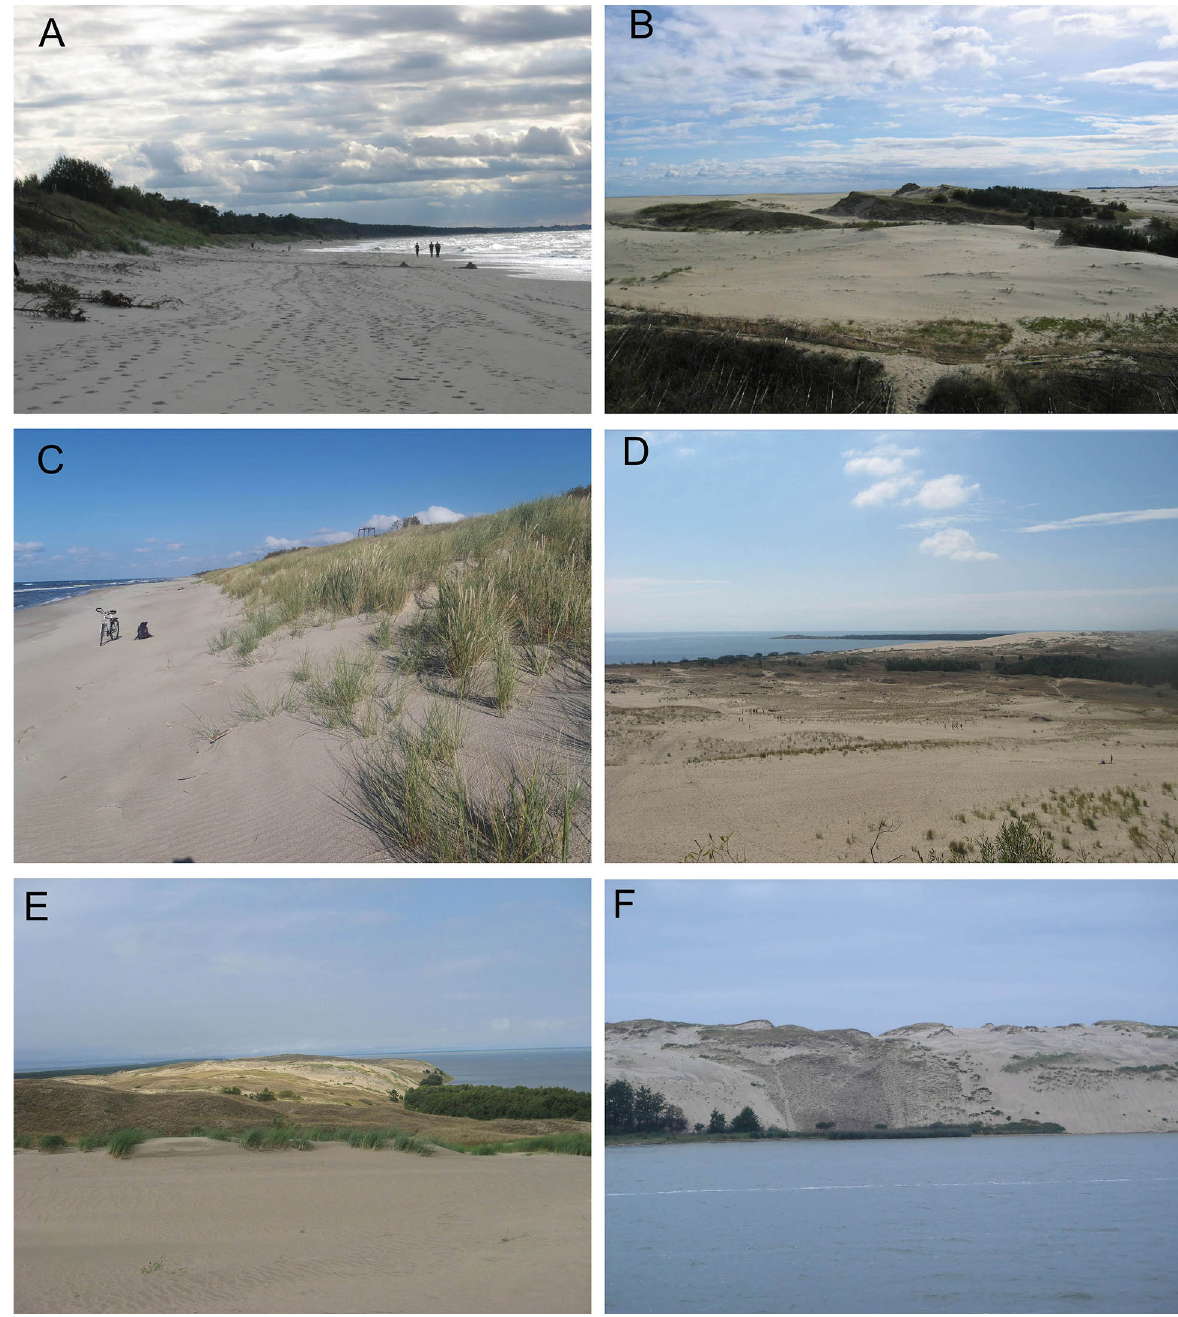
Fig. 7. Curonian Spit dunes (Photo T.